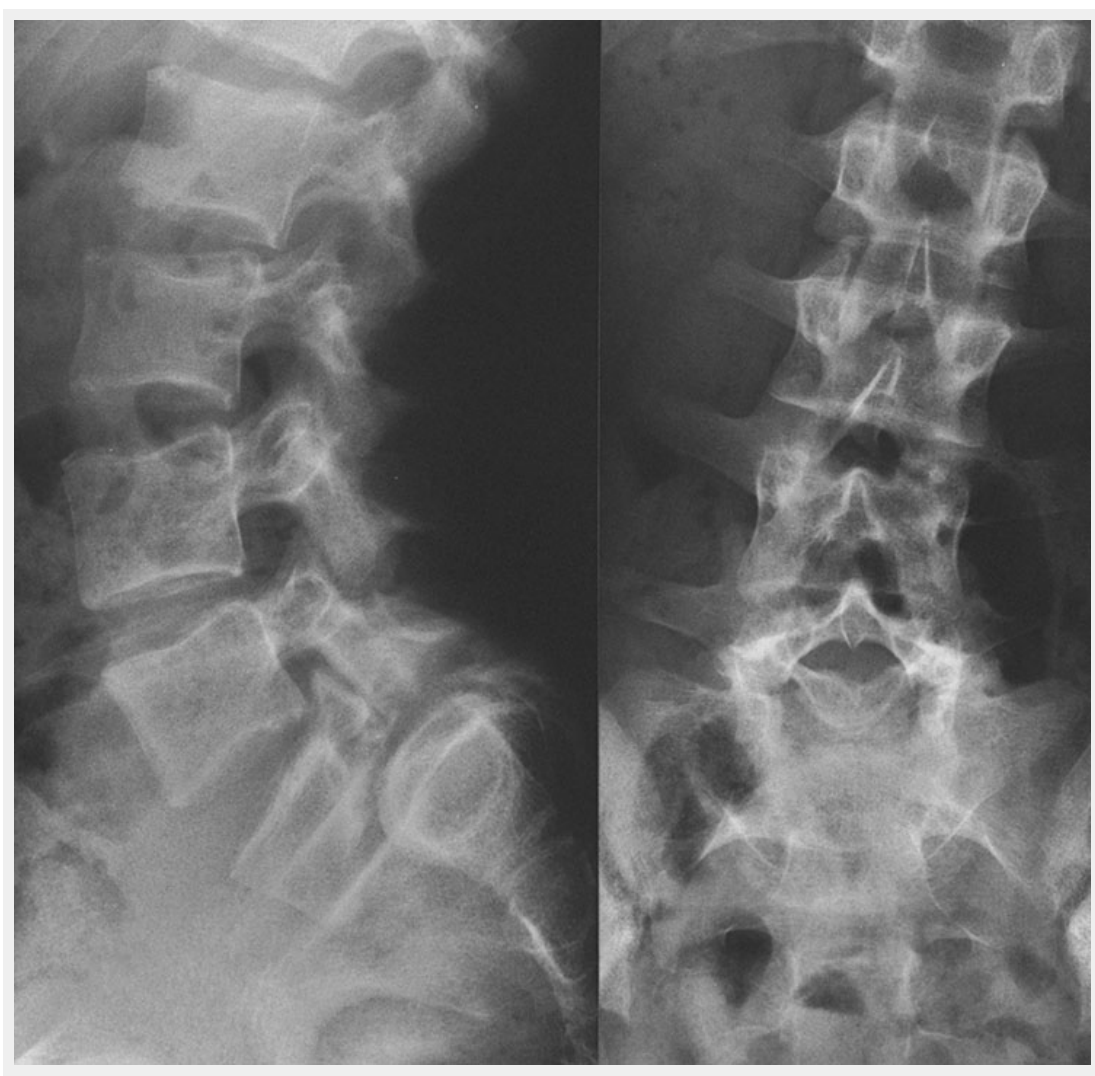
B Spondylolisthesis L5/S1 Meyerding grade IV with sacral rounding, lumbosacral kyphosis and trapezoidal shape of vertebral body L5. Spondylolysis L5. In the ap. view there is a free sight into the spinal canal L5 due to the pathologic inclination of